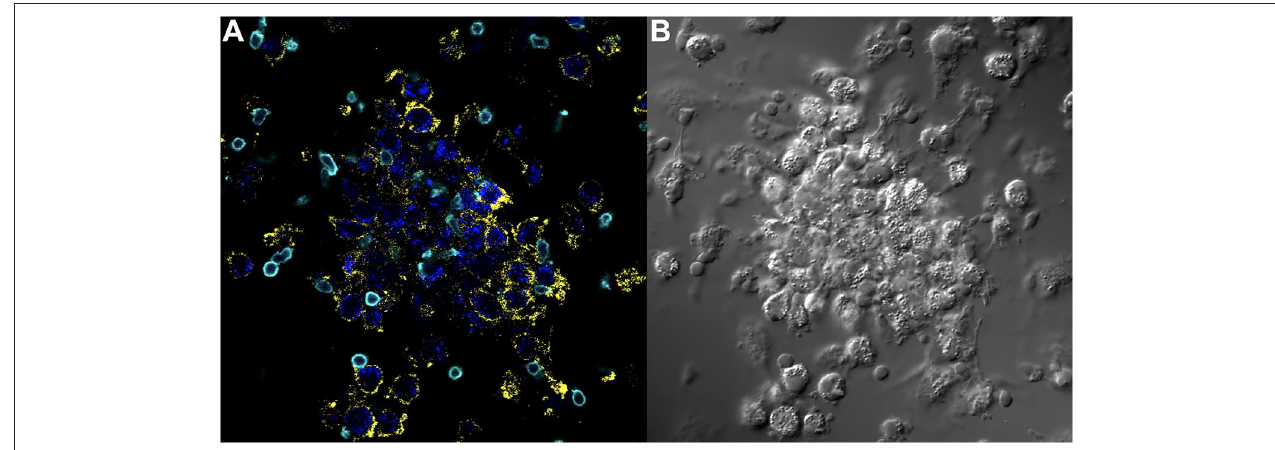
FIGURE 4 | Key immune cell populations are represented in the in vitro human granuloma model. (A) Immunofluorescence microscopy image showing CD11b + macrophages and CD3 + lymphocytes are present in a representative granuloma-like structure formed by M.tb. antigen-simulated PBMCs from a M.tb. naïve sarcoidosis patient. The image is a composite of 3 fluorescent channels: blue, yellow, and cyan channels represent the M.tb. antigen-coated beads, CD11b staining, and CD3 staining, respectively. (B) A differential interference contrast image of the same granuloma-like